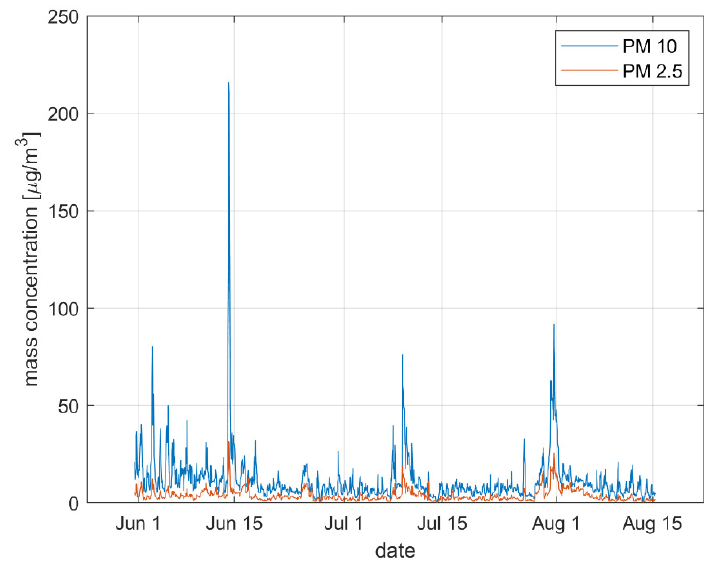
Figure 3. Hourly PM 10 ( blue ) and PM 2.5 ( orange ) concentration ([ µ m m − 3 ]) measured at Njorvasund, Reykjavik, by the Environment Agency of Iceland, from June 1 to 15 August, 2019.